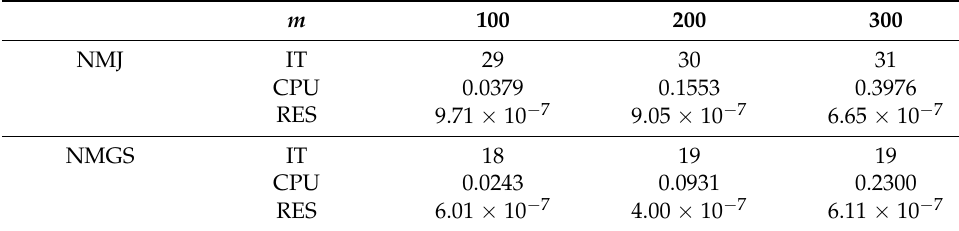
Table 2. Numerical results for Ω = 1.5 I .